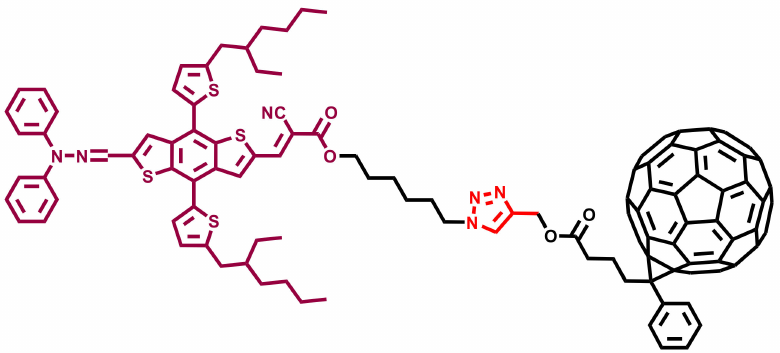
Figure 2. Illustration of the two molecules studied